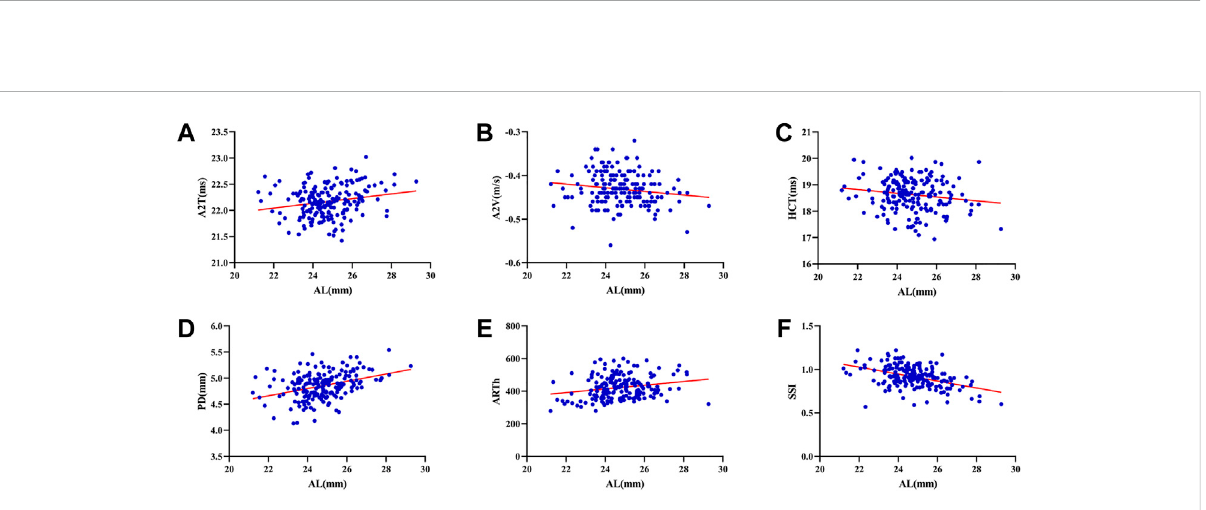
FIGURE 2 Cornealbiomechanicalparametersweresigni fi cantlycorrelatedwiththerefractiveerror.ALwassigni fi cantlycorrelatedwithA2T( r =0.205, p